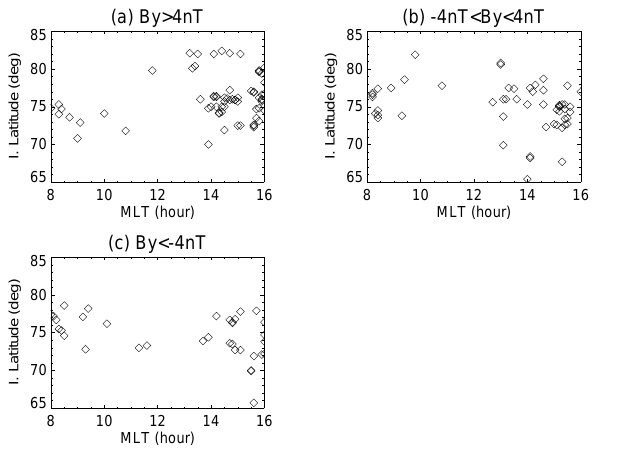
Fig. 3. Location of energetic ( > 100eV) ion conics event in MLT- I.Lat coordinate when IMF B z is (a) strongly positive, (b) nearly zero, and (c) strongly